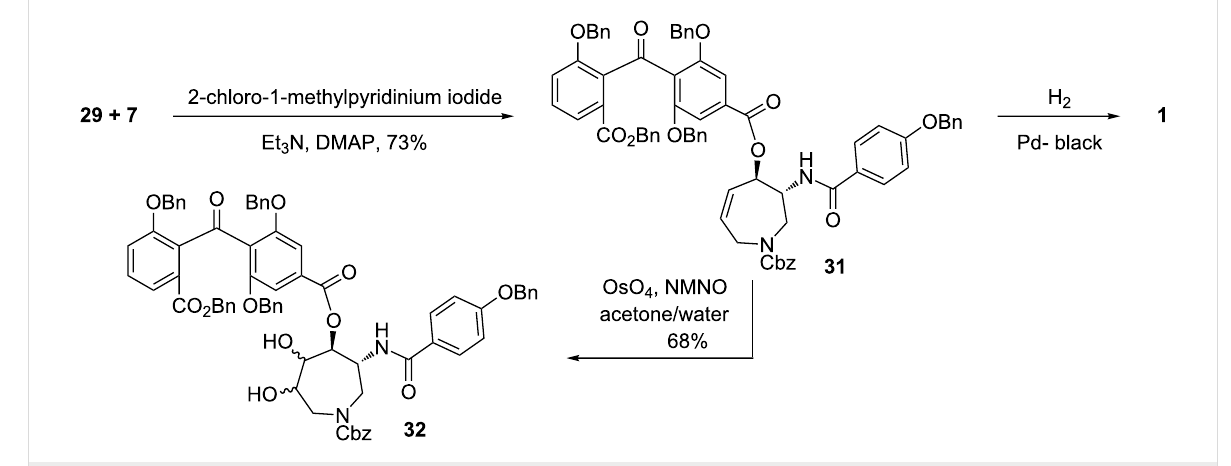
Scheme 3: Synthesis of balanol and an